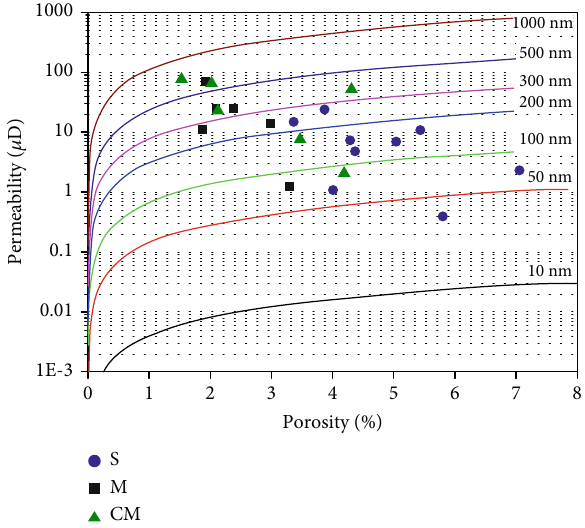
Figure 17: The crossplot of Klinkenberg-corrected permeability versus porosity along with the lines based on the Winland equation [59] for di ff erent values of r p 35